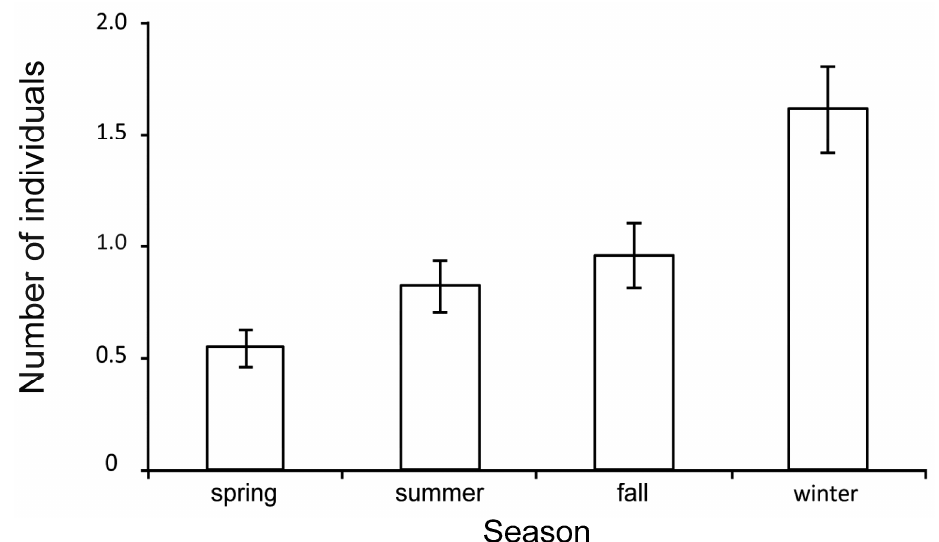
Figure 2. Estimated mean number ( ± SE) of Corvus corone and C. cornix observed in four seasons in the federal state of Vorarlberg, Austria.